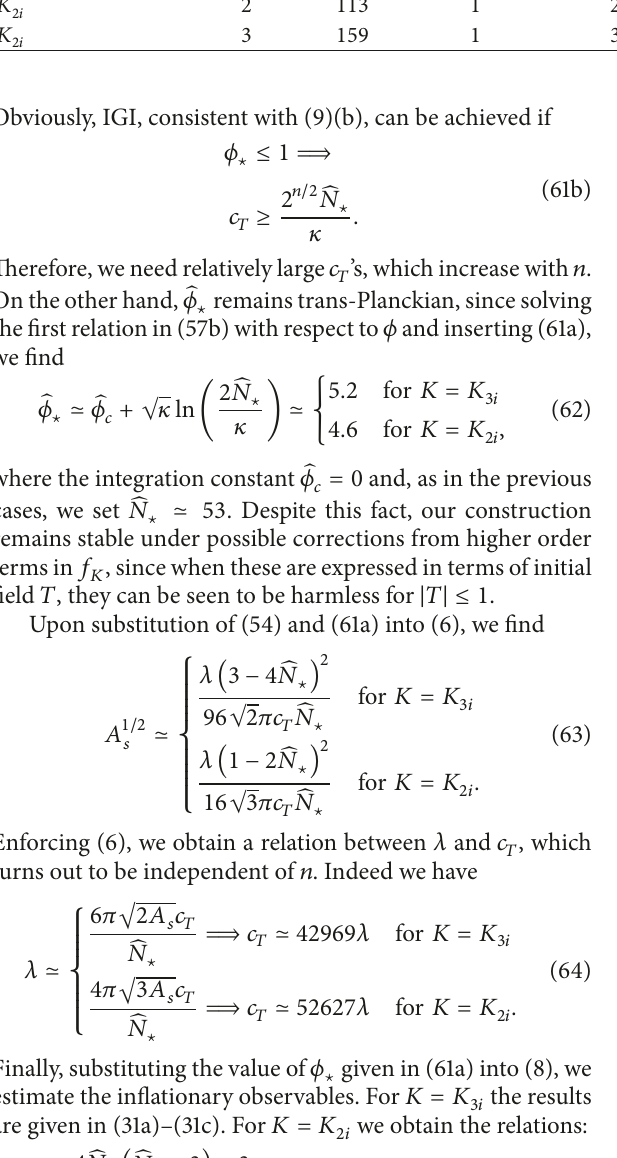
Table 3: Input and output parameters of the models which are compatible with (4) for K¨ahler potential 𝐾 Input Output 𝑛 𝑐 𝜙 𝑇 ⋆ 𝐾 1 1 54.5 3𝑖 1 1 80 𝐾 2𝑖 𝐾 2 77 3𝑖 𝐾 3𝑖